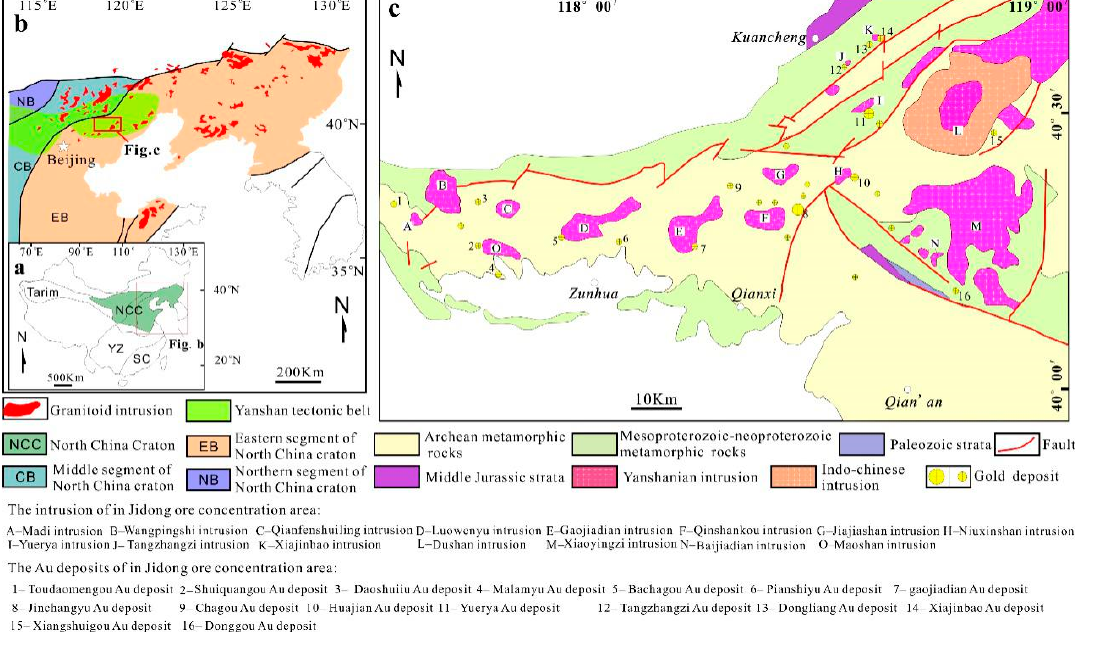
Figure 1. Simplified geological maps: ( a ) Major tectonic divisions of China; ( b ) Sketch map showing distribution of the Triassic to Jurassic granitic intrusions in the eastern NCC; ( c ) Simplified geological map of eastern Hebei Province (Modified from Mei [4] and Song et al. [5]).